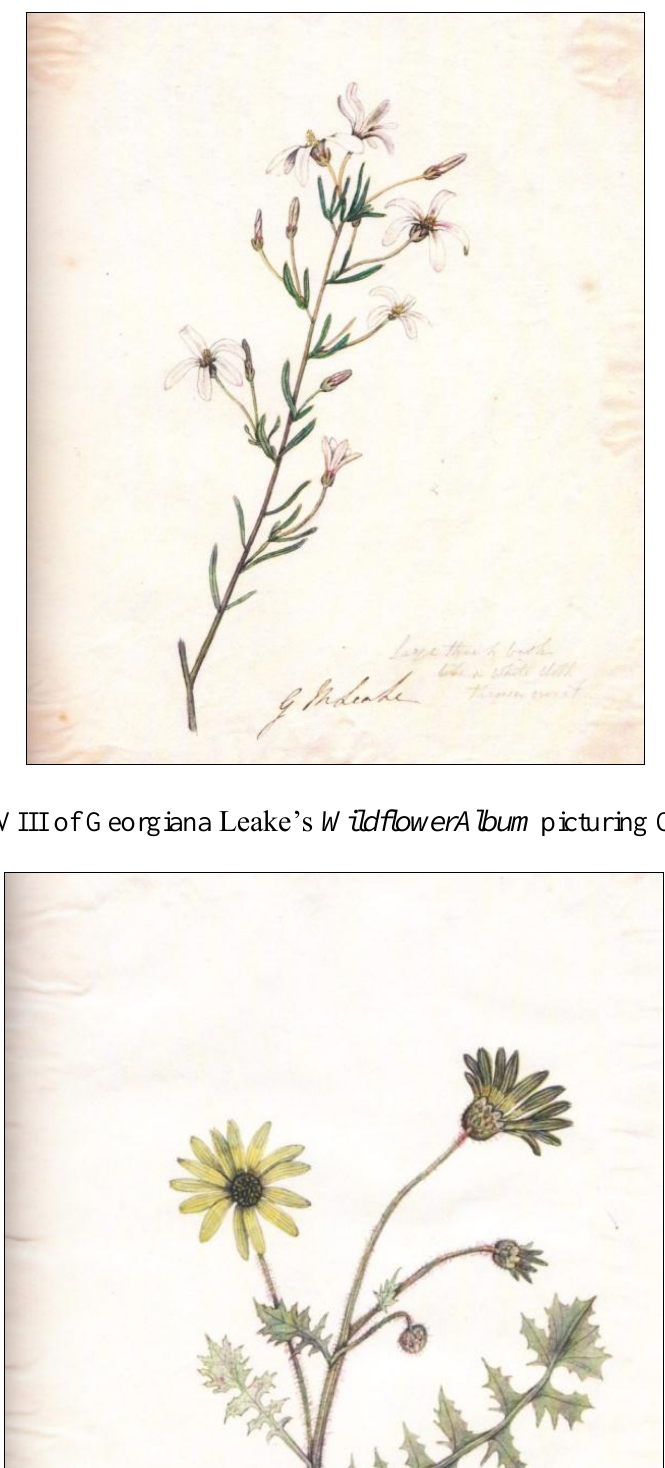
Figure 2 . Plate XXII of Georgiana Leake’s Wildflower Album featuring Wedding Bush.